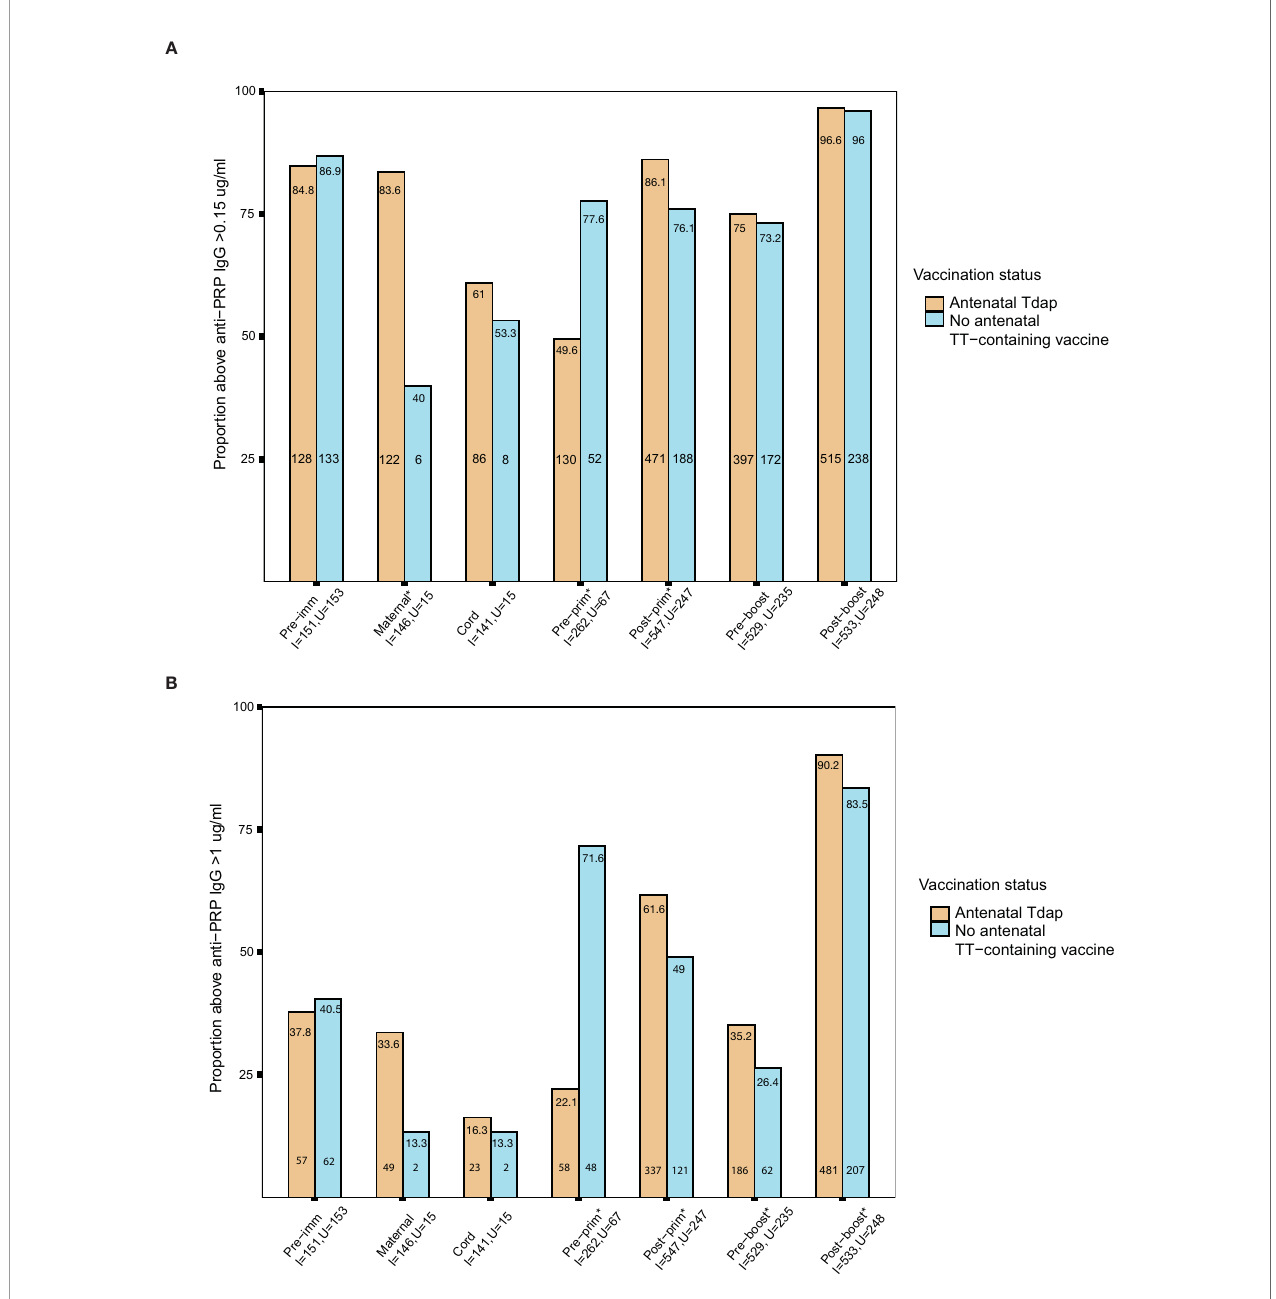
FIGURE 6 | (A) Short-term seroprotection rates against haemophilus in fl uenzae type b (Hib) disease. Rates of subjects with anti – polyribosylribitol phosphate (PRP) IgG ≥ 0.15 mcg/ml in women immunized with tetanus-diphtheria-acellular pertussis (Tdap) versus women who did not receive Tdap vaccine, diphtheria and tetanus toxoids (dT) or tetanus-toxoid (TT) vaccine in pregnancy pre- immunization and at delivery; in infants born to women immunized Tdap versus infants of women not immunized with Tdap, dT or TT vaccine in pregnancy pre-primary, post-primary, pre-booster and post-booster immunization with diphtheria-tetanus-acellular-pertussis-Hib vaccine (*comparisons where p-values <0.05). P-values: Pre-imm: p= 0.707; Maternal: p<0.001 ; Cord: p=0.765; Pre-prim: p<0.001 ; Post-prim: p= 0.001 ; Pre-boost: p= 0.651; Post-boost:p=0.801. (B) Long-term seroprotection rates against Hib disease. Rates of subjects with anti – PRP IgG ≥ 1 mcg/ml in women immunized with Tdap versus women who did not receive Tdap, dT or TT vaccine in pregnancy pre- immunization and at delivery; in infants born to women immunized Tdap versus infants of women not immunized with Tdap, dT or TT vaccine in pregnancy pre-primary, post-primary, pre-booster and post-booster immunization with diphtheria-tetanus-acellular- pertussis-Hib vaccine (*comparisons where p-values <0.05). P-values: Pre-imm: p= 0.705; Maternal: p= 0.189; Cord: p=1; Pre-prim: p<0.001 ; Post-prim: p= 0.001 ; Pre-boost: p= 0.021 ; Post-boost: p=0.009 . Seroprotection rates were compared using the chi-squared test. Pre-imm, pre-immunization; Pre-prim, pre-primary; Post- prim, post-primary; Pre-boost, pre-booster; Post-boos, post-booster; I, immunized; U, Unimmunized. Absolute numbers are shown in the bottom and percentages in the top of the